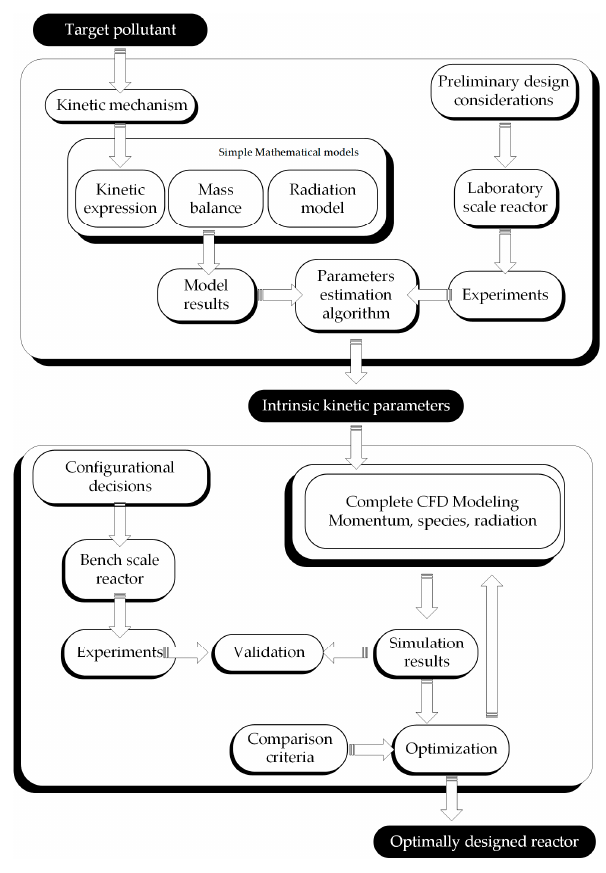
Figure 1 . Conceptual framework of the integral design methodology. Figure 1. Conceptual framework of the integral design